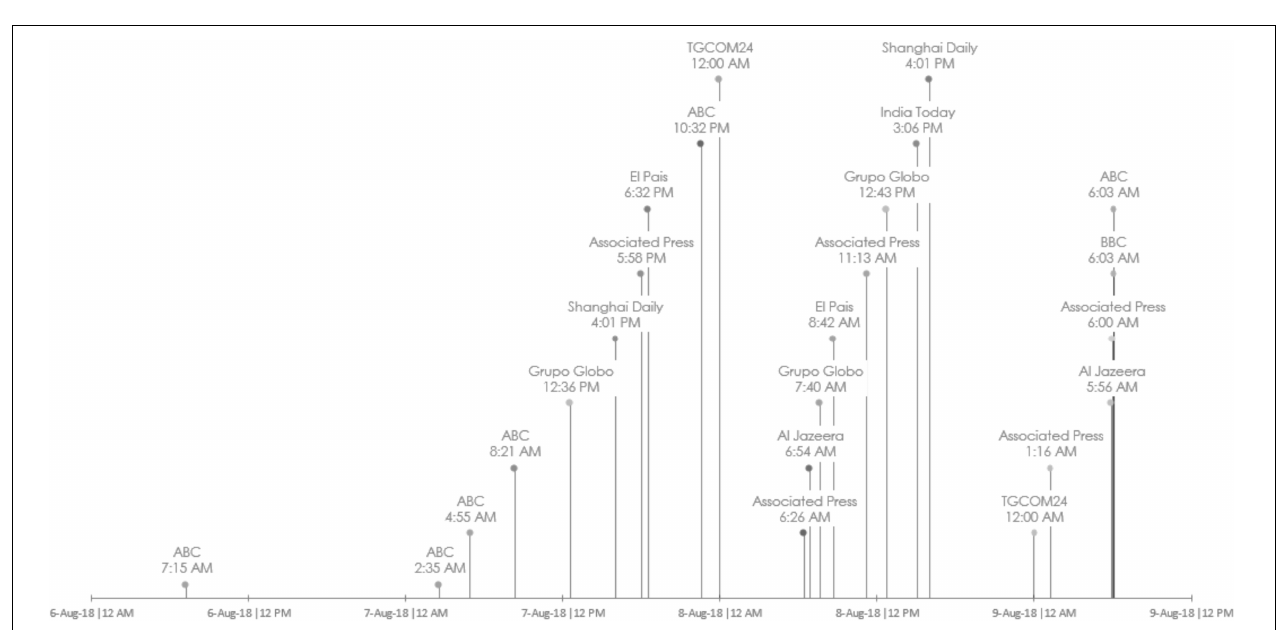
FIGURE 4 | Graphs showing the relationship of published articles with the number of global earthquakes and earthquake magnitude. (A) Ratio of number of articles per earthquake sorted by magnitude. (B) Number of articles with the corresponding magnitude ranges. Dashed line is the modeled number of articles (Correlation coefficient of 0.88, and R-squared value of 0.78). Diamond symbols show the number of earthquakes listed in the 2018 USGS catalog.